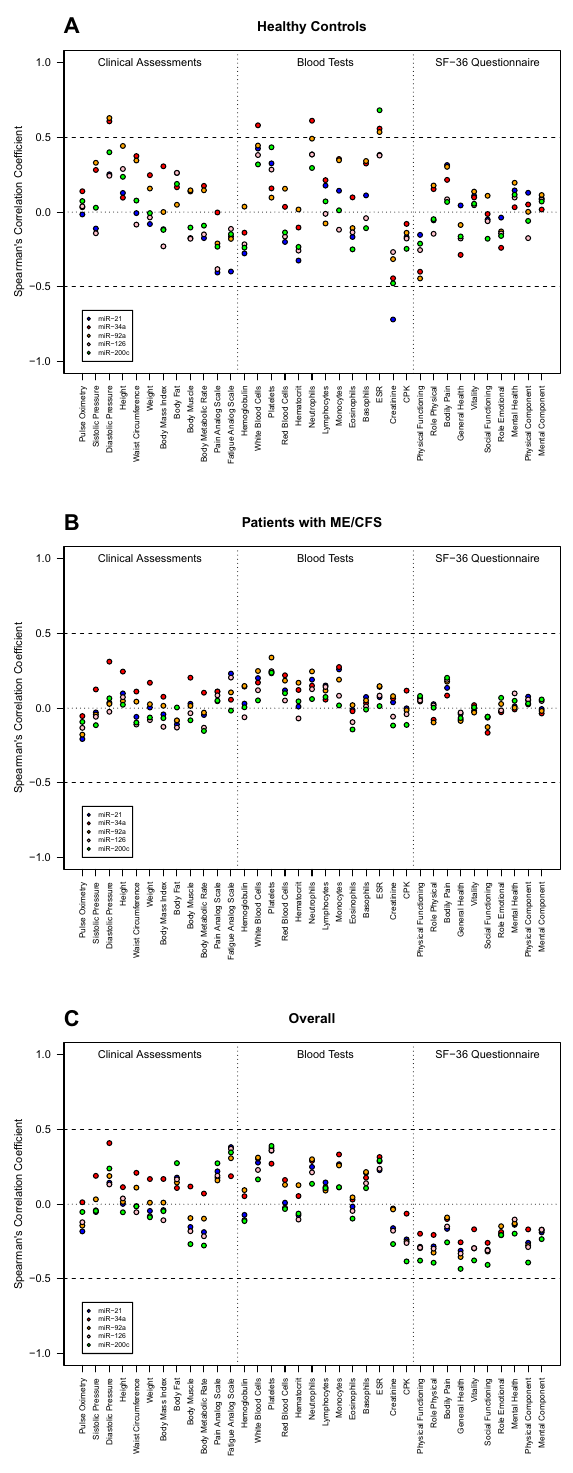
Figure 4. Correlation analysis between miR expression and clinical-related data. A pairwise correlation analysis between data of each miR and data of each clinical, blood and SF-36 variable was conducted using Spearman’s correlation coefficient. A. Correlation analysis using the data of healthy controls only. B. Correlation analysis using the data of patients with ME/CFS only. C. Correlation analysis using data irrespective of the study groups. The statistical analysis was performed in the R software version 4.0.2 (https:// www.r- proje ct.